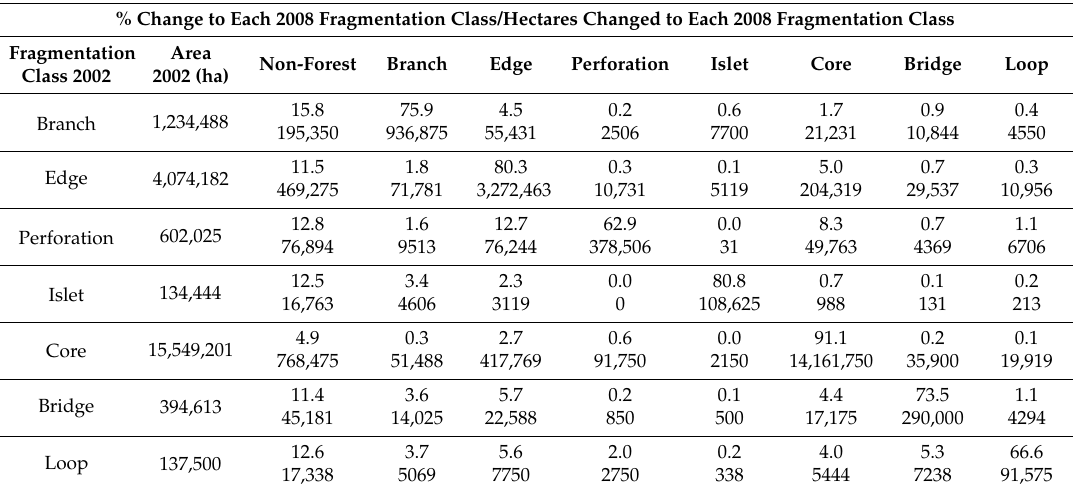
Table B2. Fragmentation classes transition matrices for temperate forest in the 2002–2008 period without differentiating between internal and external